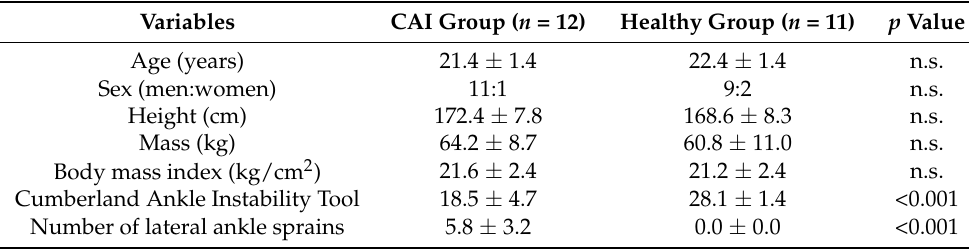
Table 1. Participant Demographic